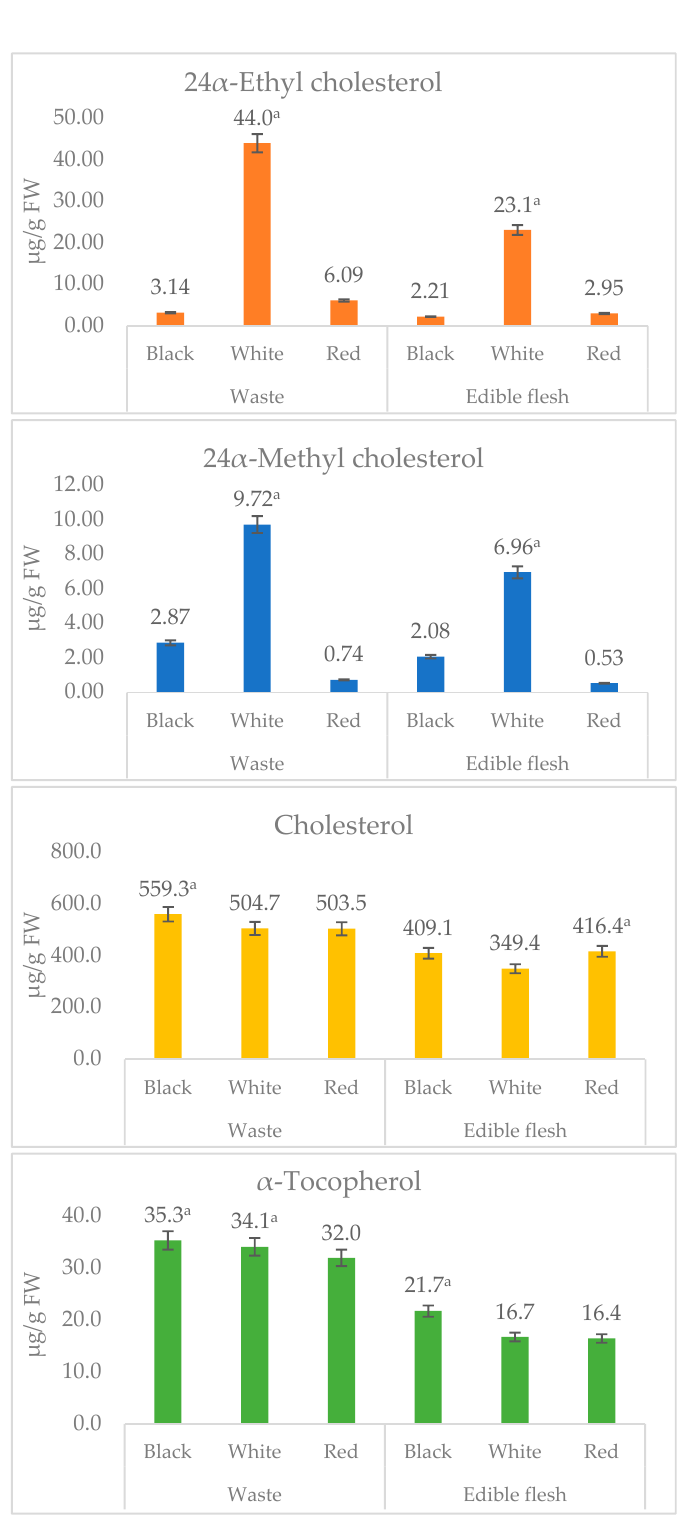
Figure 5. The content of α -tocopherol, and sterols in waste and edible flesh of three shrimp species. Values are mean ± standard deviation of three replicate determinations. a The mean value is significantly ( p < 0. 05) highest among the processing waste or edible flesh obtained from black (black tiger), white (whiteleg), red (Argentine red) shrimp.